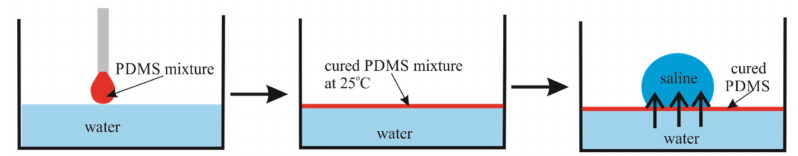
Figure 1. Schematic representation of the PDMS membrane preparation method.